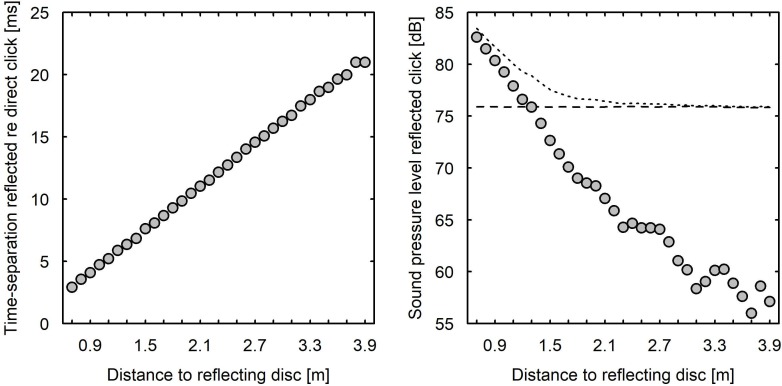
Time separation and SPL of the reflection as a function of distance to the disk.Time separation between direct and reflected click (left), and SPL (1 ms running rectangular window) of the reflected click as a function of distance from the reflecting disk in m (right).The horizontal dashed line in the right panel refers to the SPL of the direct click, and the dotted curve refers to the combined SPL of direct and reflected clicks.